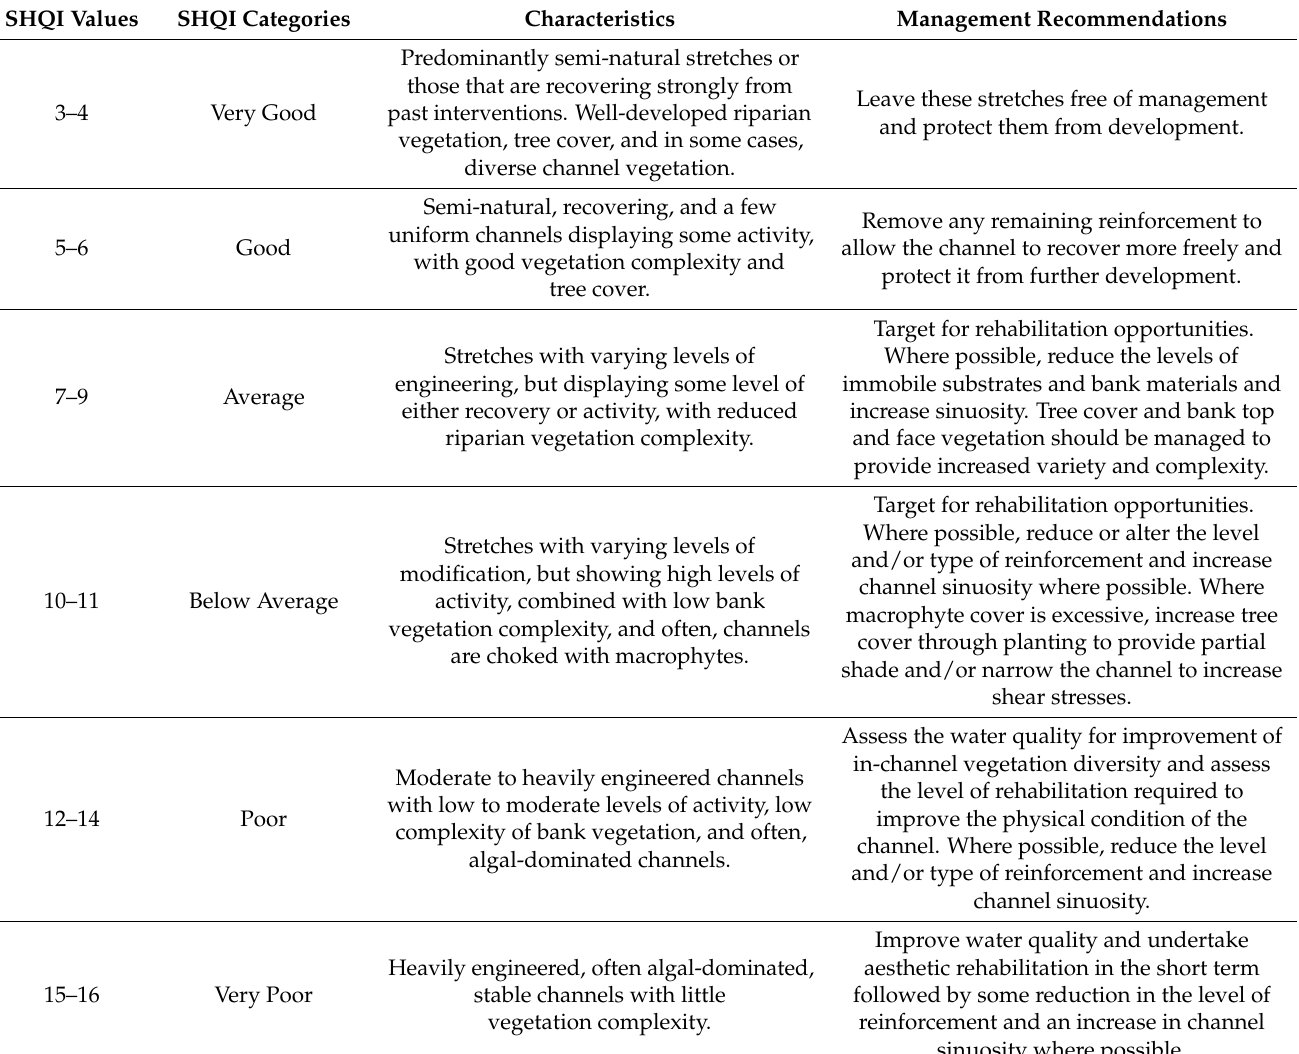
Table 4. SHQI values and categories, associated characteristics, and management recommendations to improve physical habitat quality and diversity (developed from